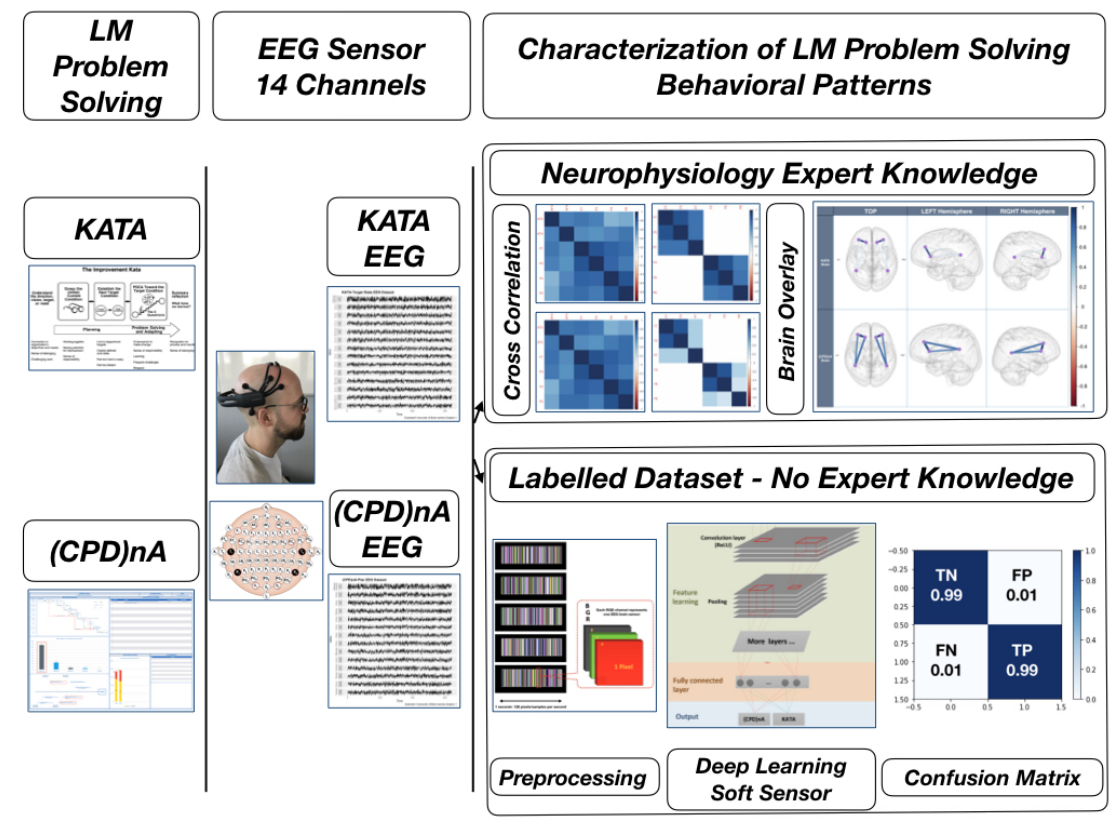
Figure 1. Graphical